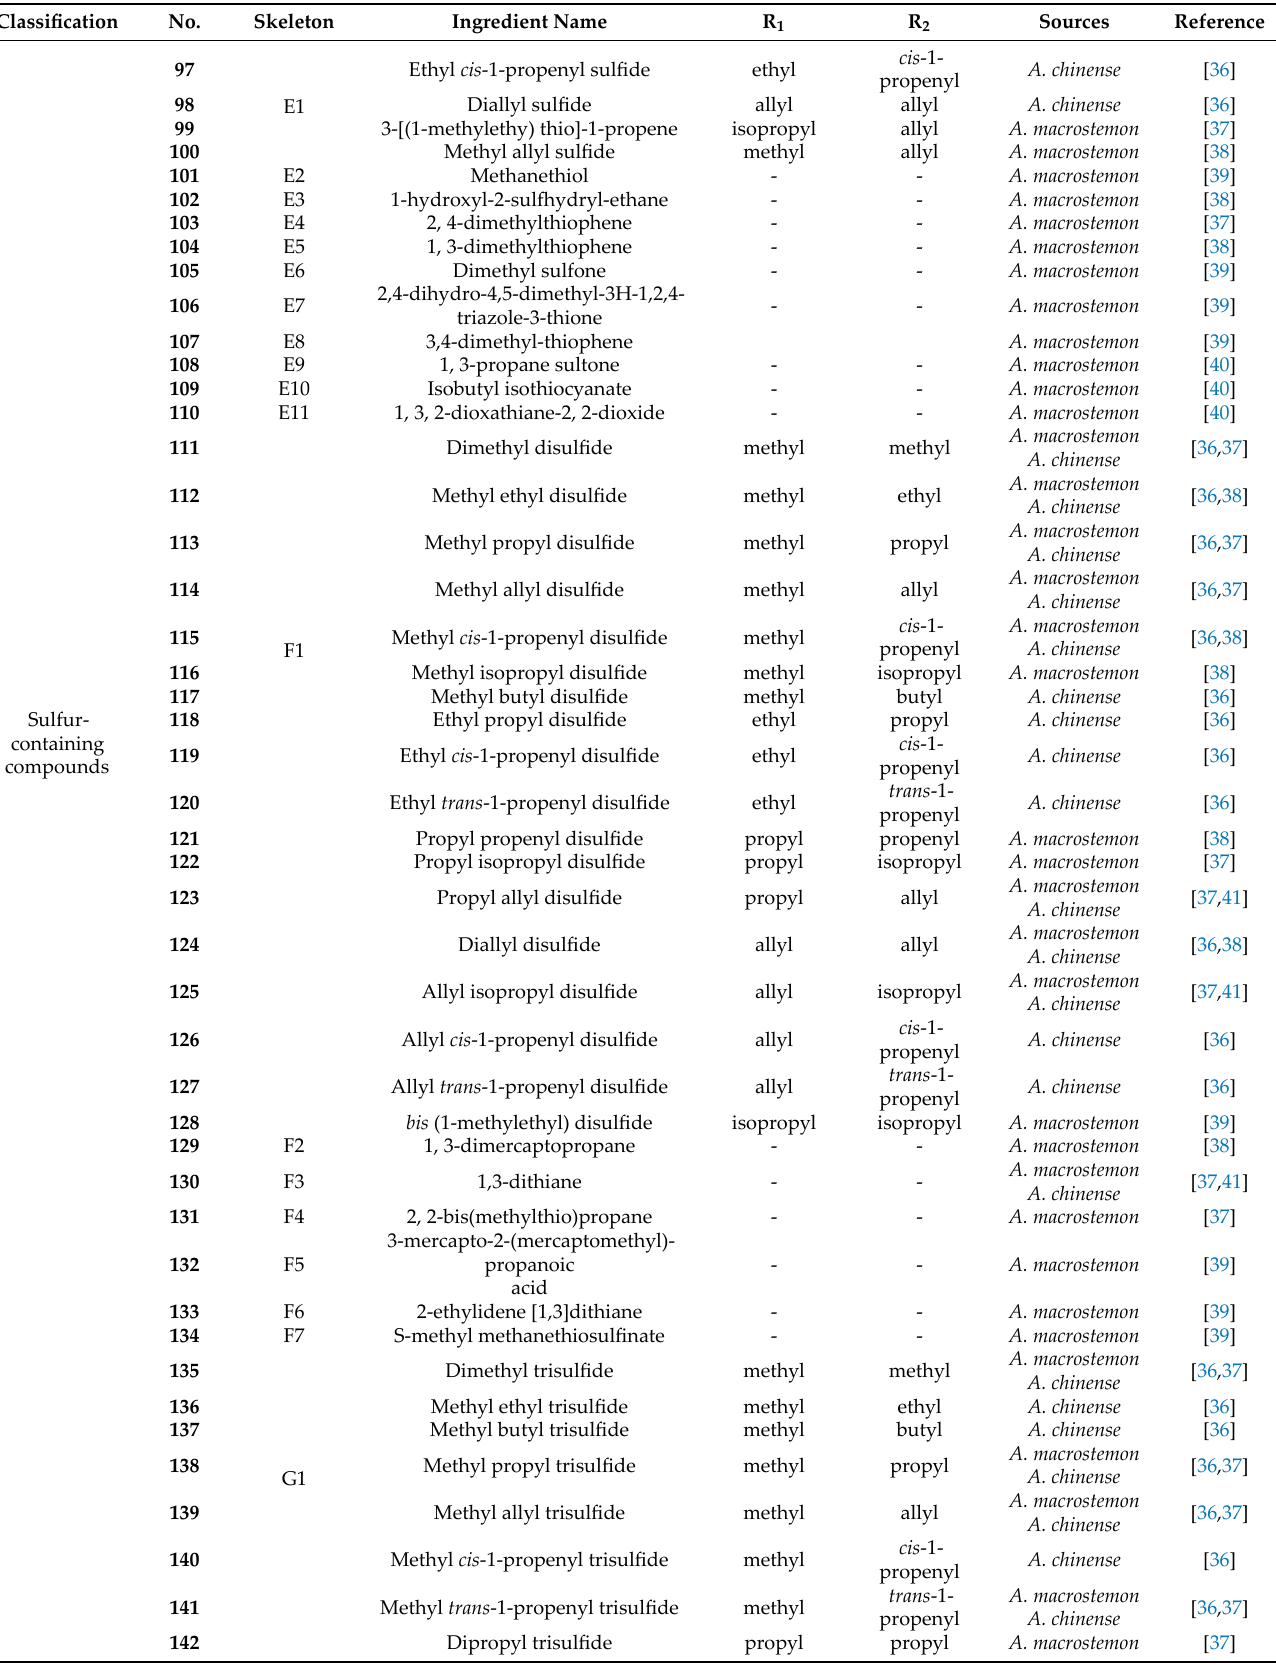
Table 5. List of sulfur‑containing compounds previously identified from